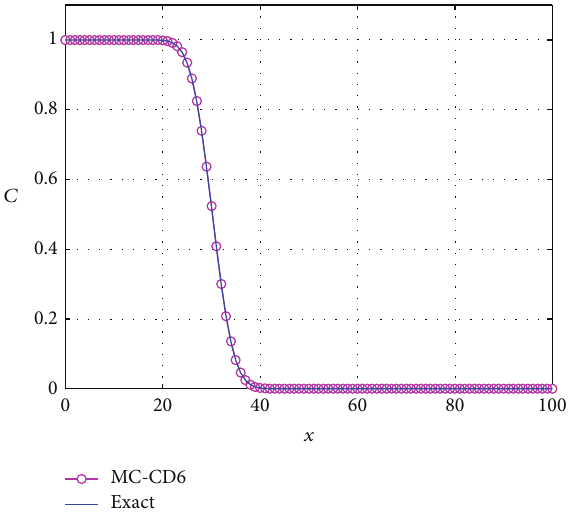
Figure 1: Comparison of the exact solution and the numerical solution obtained with MC-CD6 scheme for 𝑡 = 3000 s.